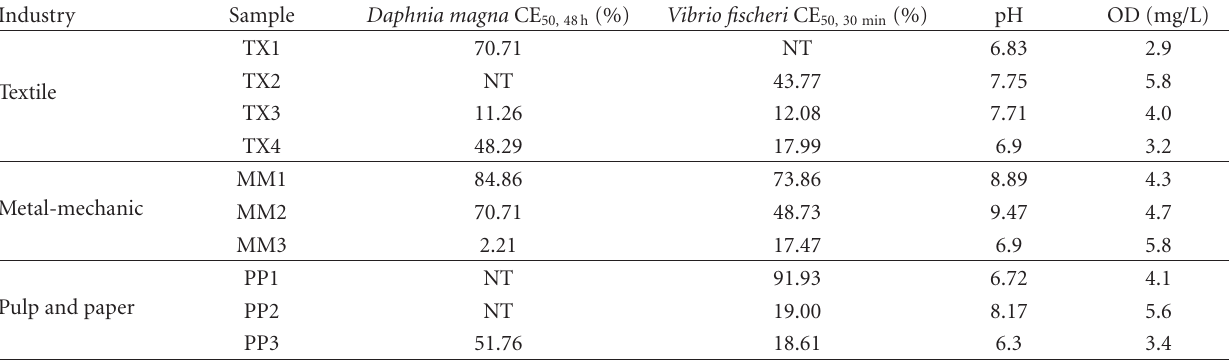
Table 2: Results of Daphnia magna and Vibrio fischeri acute toxicity tests after exposition to soluble fraction of textile, metal-mechanic, and pulp and paper industrial solid waste.